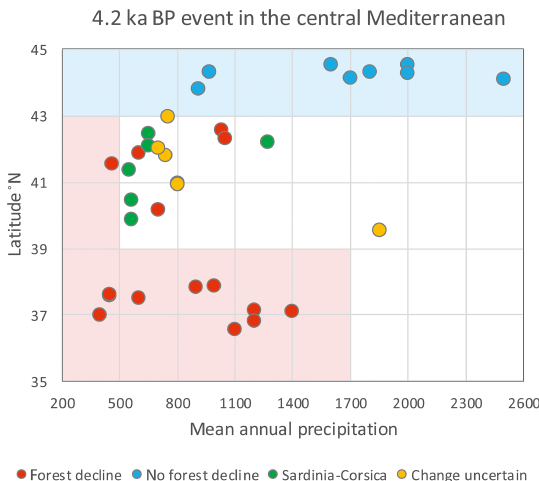
Figure 3. The latitude of the pollen records from the central Mediterranean is plotted against the respective mean annual pre- cipitation. Red dots represent the pollen sites where a deforesta- tion is clear during the 4.2ka event, and blue dots represent sites where there is no deforestation at 4.2ka; green dots represent sites from Corsica and Sardinia, where there is a compositional change in vegetation, but no overall deforestation; yellow dots represent sites showing unclear vegetation changes around